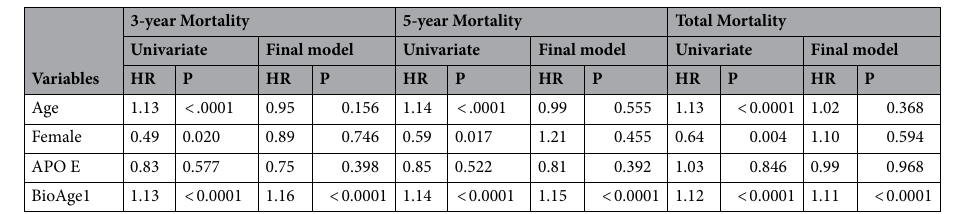
Table 4. Association of BioAge1, 3-Year, 5-Year and total all-cause Mortality: The Rotterdam Study, 2002– 2012.